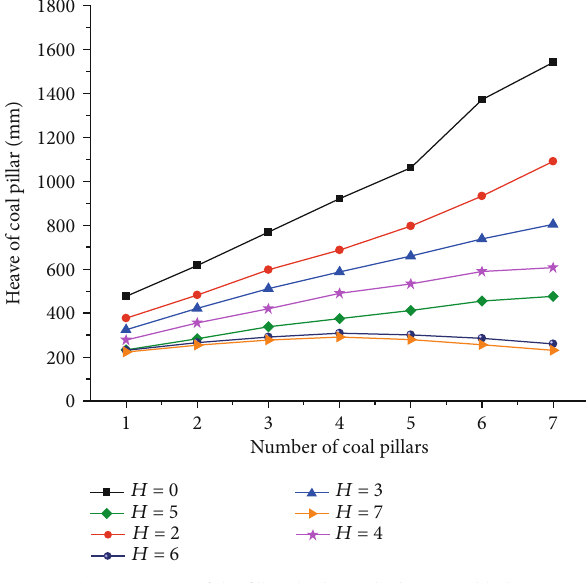
Figure 10: Suppressing e ff ect of di ff erent fi lling body heights on the expansion of the plastic zone and the amount of the horizontal bulge of each coal